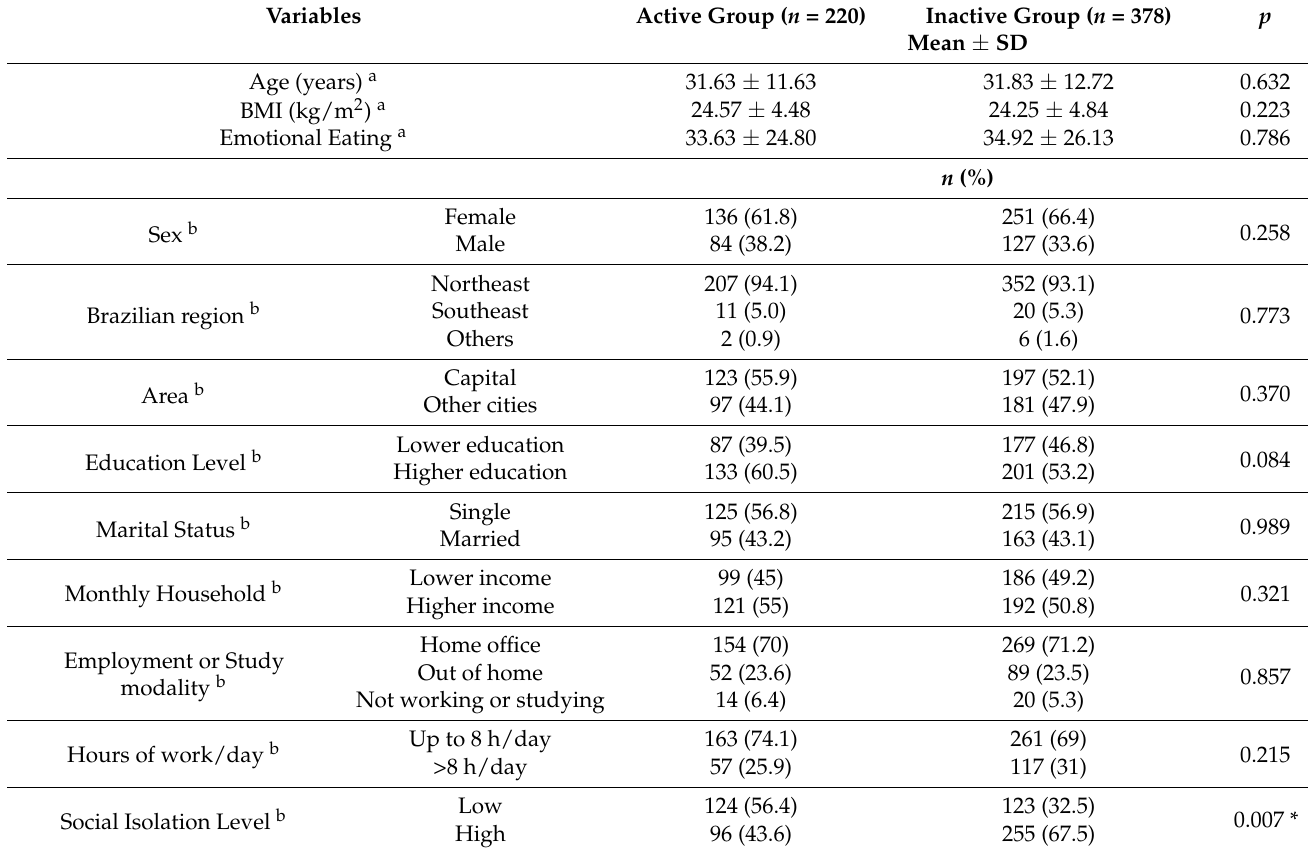
Table 1. Descriptive analysis by level of physical activity. Brazil, 2021 ( n =